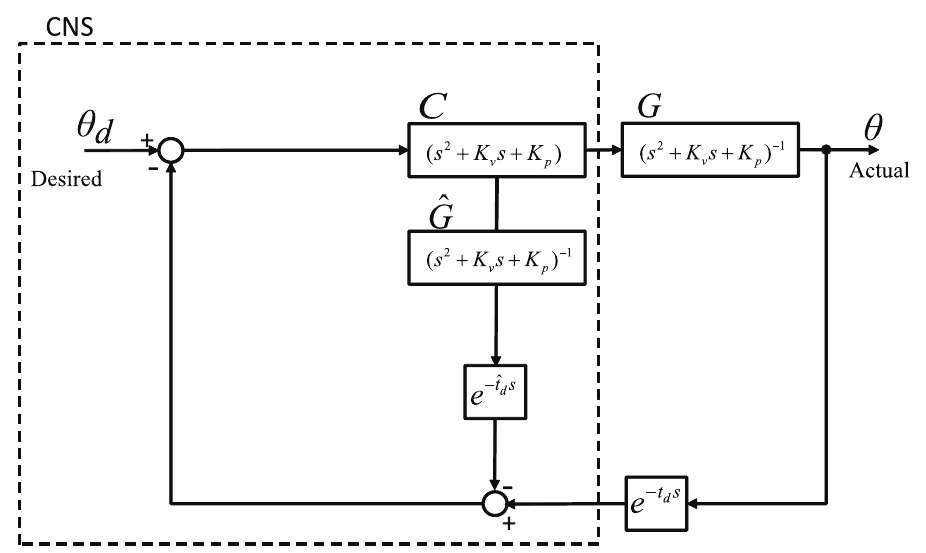
Fig 4. Simplified block diagram of TDC in the architecture of the Smith predictor. The controller in this control architecture can match with the controller C of the Smith predictor and the linearized plant with the plant G of the Smith predictor. The forward model equals to the plant linearized by this